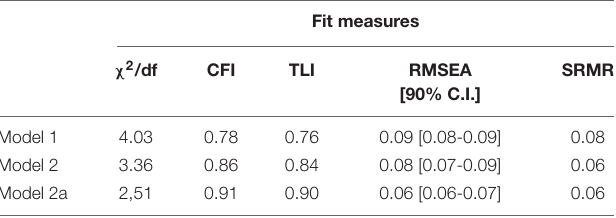
TABLE 3 | Goodness-of-fit indices for the Revised CL-FODS four factor structure ( n = 383 –CFA).